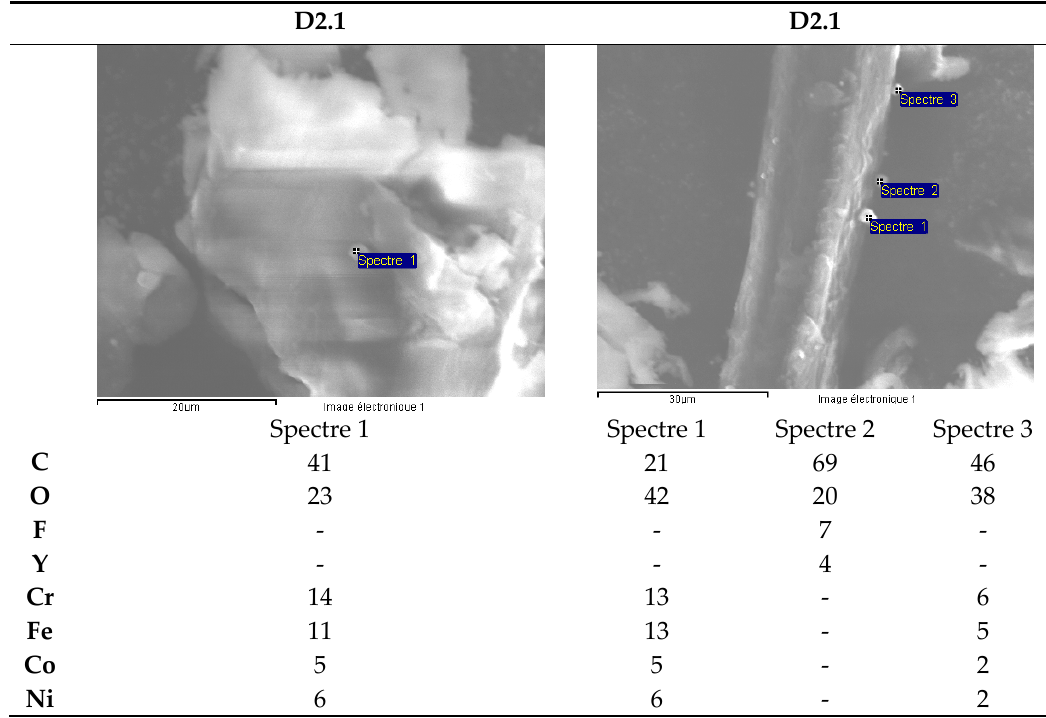
Figure 13. Black ceramic watch band (D2.1). SEM analysis of microfibers from filter paper.